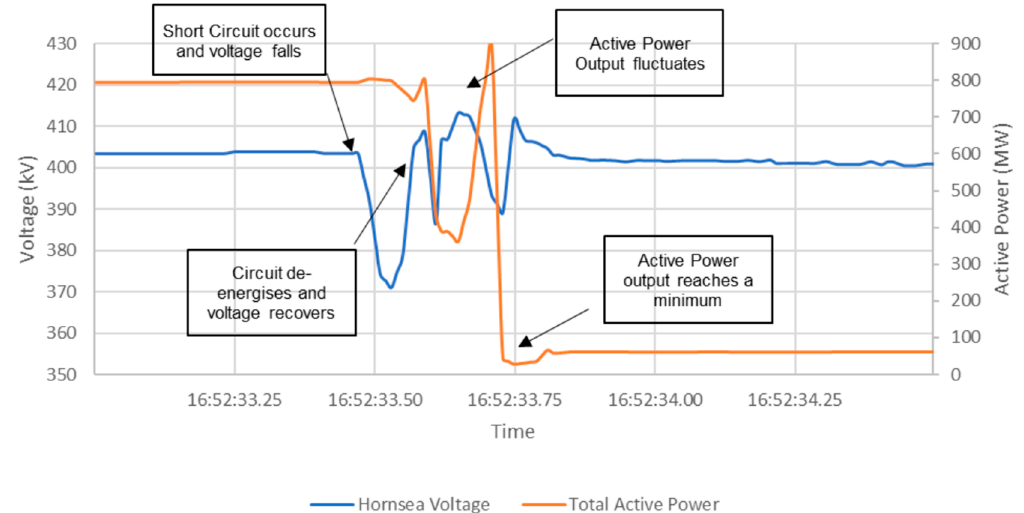
Figure 4. Voltage and active power at Hornsea One [2].